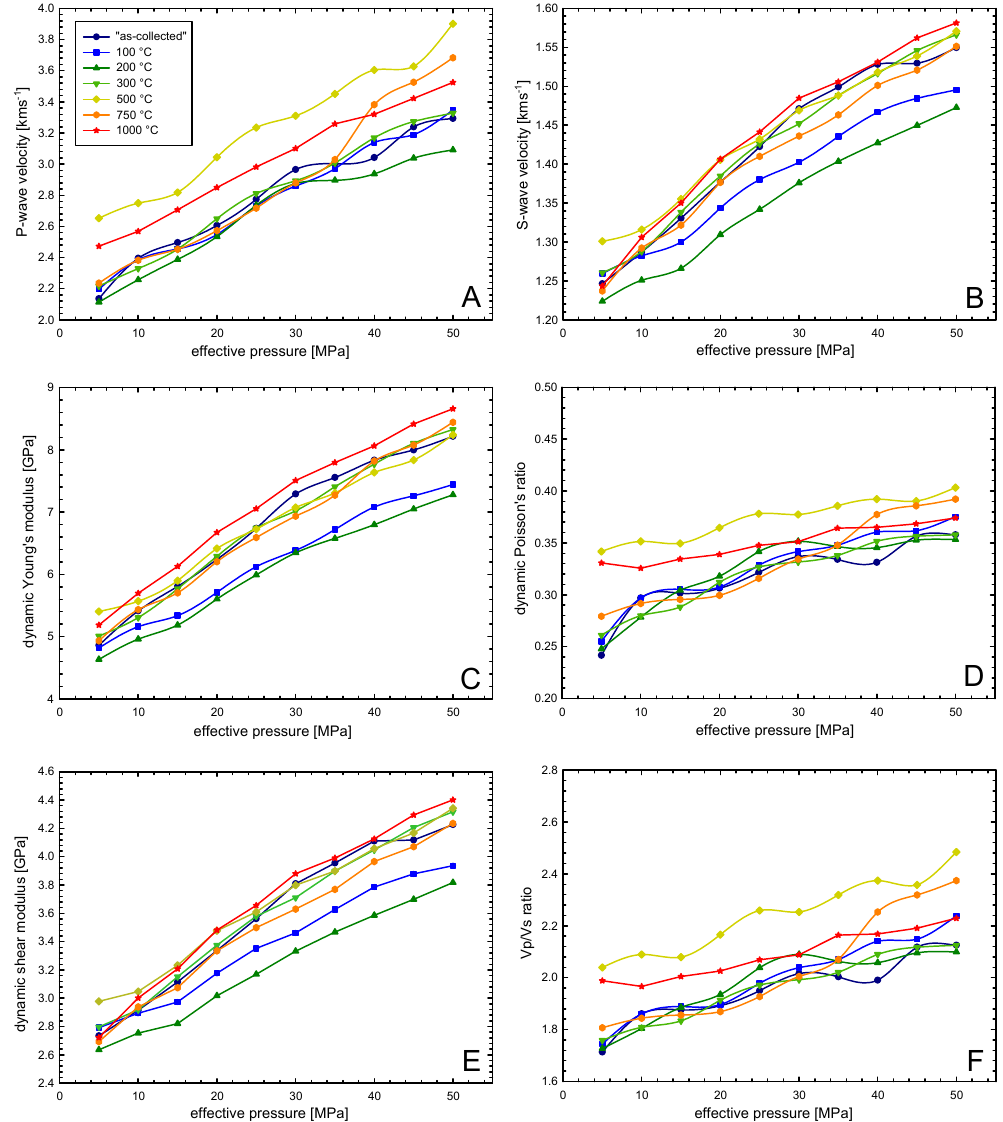
Fig. 8. The evolution of P wave velocity (A) , S wave velocity (B) , dynamic Young’s modulus (C) , dynamic Poisson’s ratio (D) , dynamic shear modulus (E) , and V P /V S ratio (F) with increasing effective pressure for Grey Campanian Ignimbrite. The temperatures in the legend refer to the thermal stressing temperature (see text for